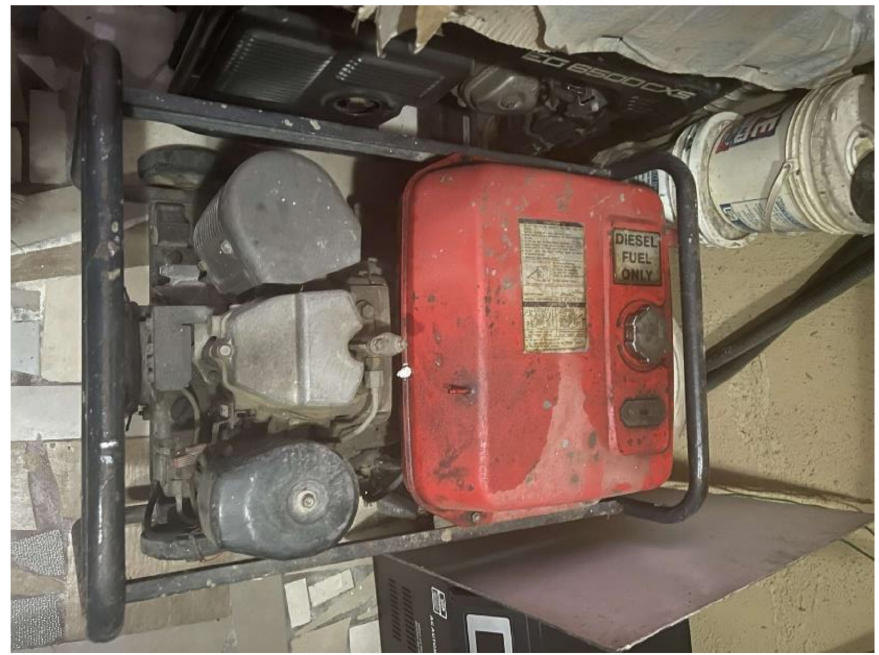
Figure 4. Domestic diesel generator in a home-Lagos, Nigeria (plan view). Source: [41].